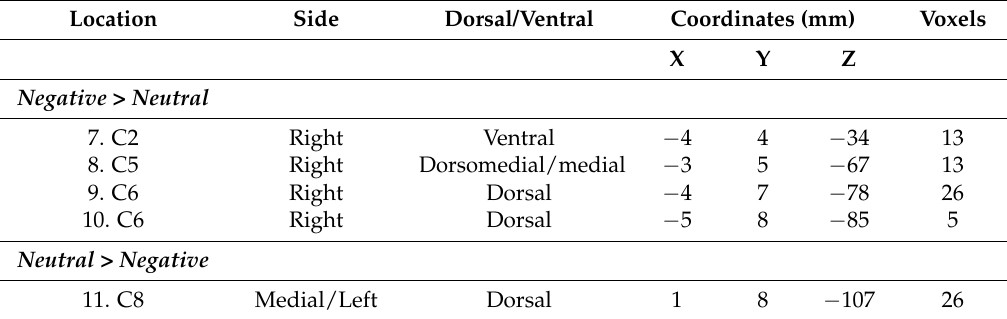
Table 2. Location of spinal cord activity in the contrast of the negative sounds and neutral sounds. Location Side Dorsal/Ventral